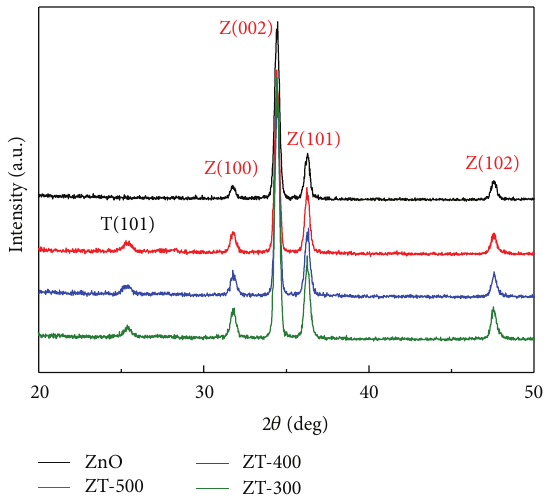
Figure 2: XRD patterns of ZT-300, ZT-400, ZT-500, and ZnO.